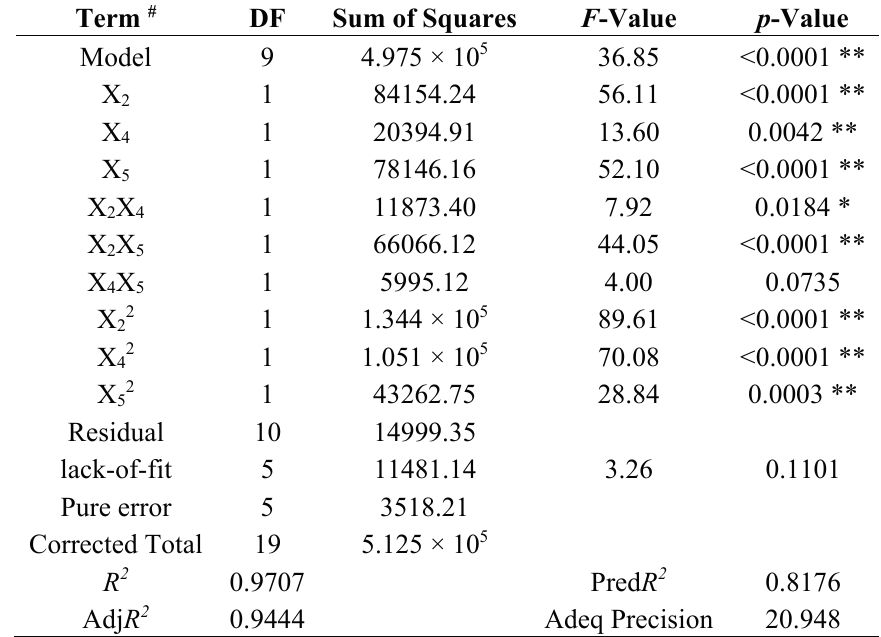
Table 4. Analysis of variance (ANOVA) for